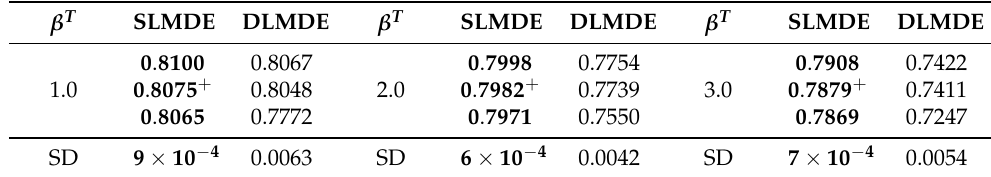
Table 1. Best, median, and worst HV values obtained by both methods are presented for Example 1 for different values of β T . The best performances are highlighted in bold font.